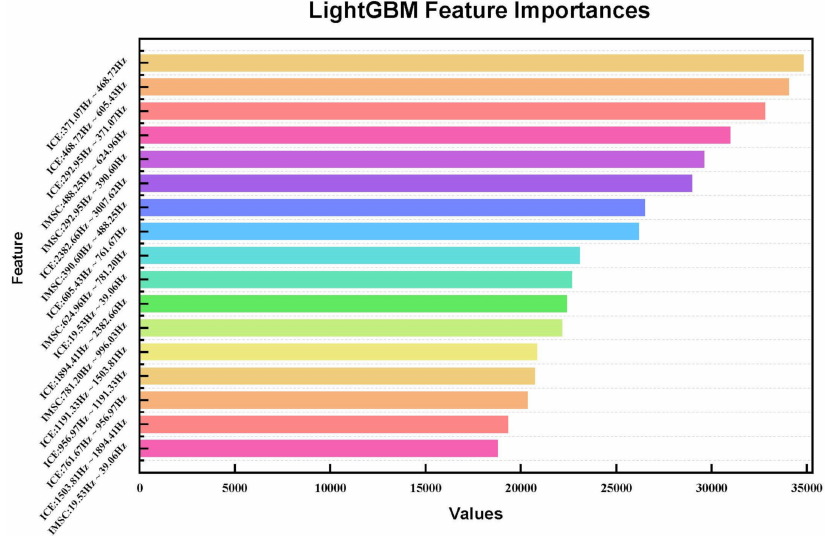
Figure 14. The features’ importance given by LightGBM model on Dataset 01. The larger the value, the more important a feature.